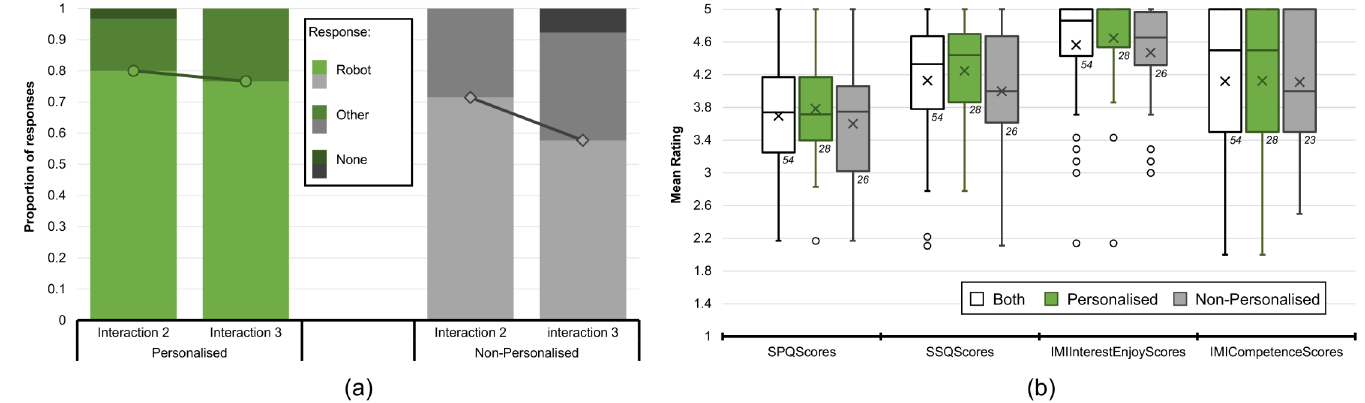
Fig 5. End-of-interaction question responses. (a) end of interactionresponses after the second and third interactionsto the question“what wouldyou prefer to play with next?”, with “none” recordedif an answer is not given within 30 seconds (multiple choice from: robot, classmates, read a book, play outside, games console,or no answer); (b) box-plots showingchild ratings for the four questionnaires (end of bars represent last datum within the 1.5 * IQR; circles denote outsidevalues; no outliers): social presence, social support, interest/enjoymentand perceivedcompetence.Crosses indicate the mean, numbers belowthe bars denote sample size.